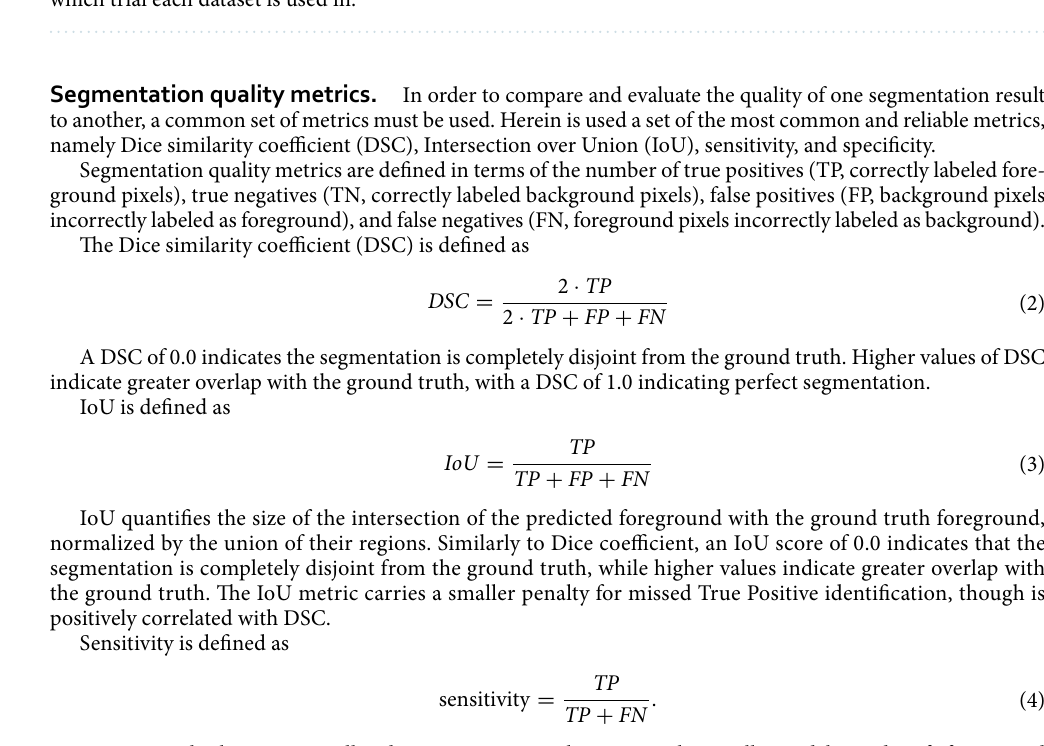
Table 2. Summary of the datasets used for evaluating the network in different trials. The last column indicates which trial each dataset is used